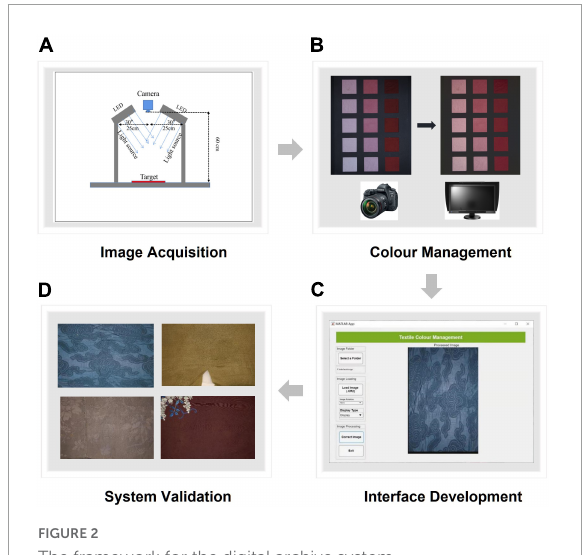
FIGURE2 The framework for the digital archive system.